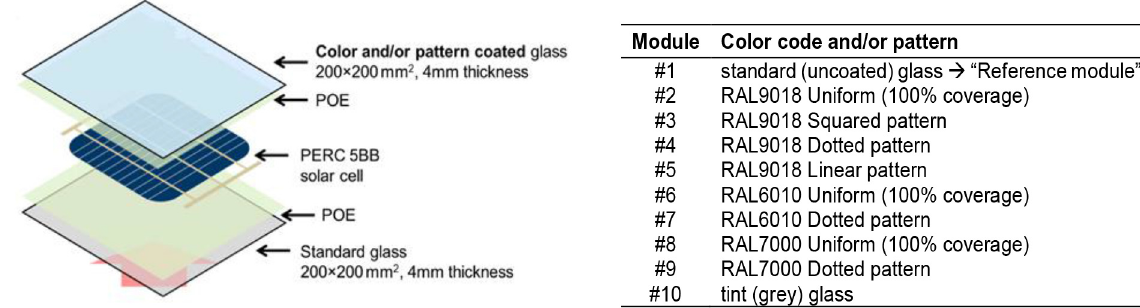
Fig. 3. The applied layout for the different PV laminates of the study (left) and the 10 colored/patterned glazings